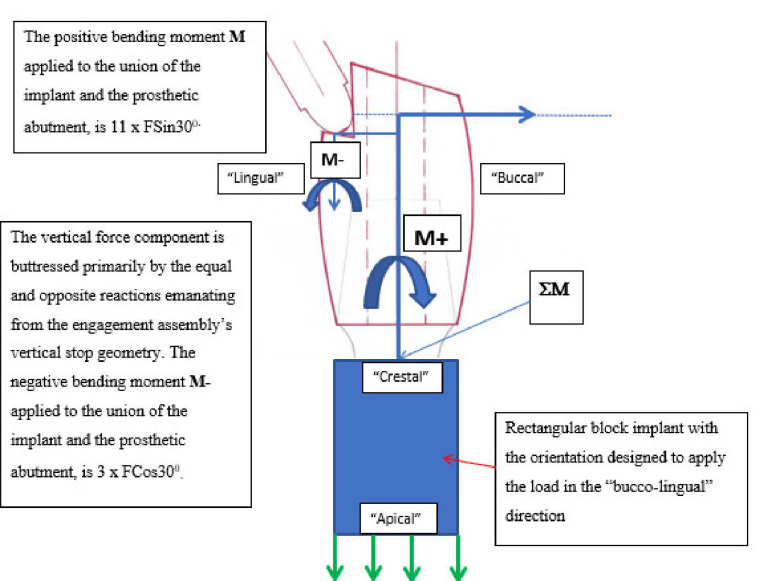
Figure 3. Test assembly: crestal region moments generated. The residual axial forces (green arrows) would be expressed